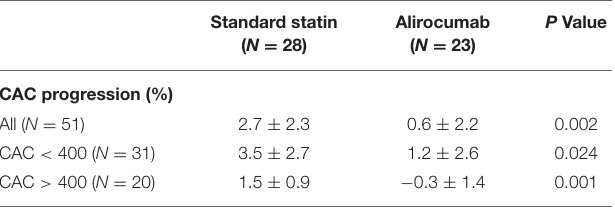
TABLE 3 | Stratified comparison of CAC progression with baseline CAC score.